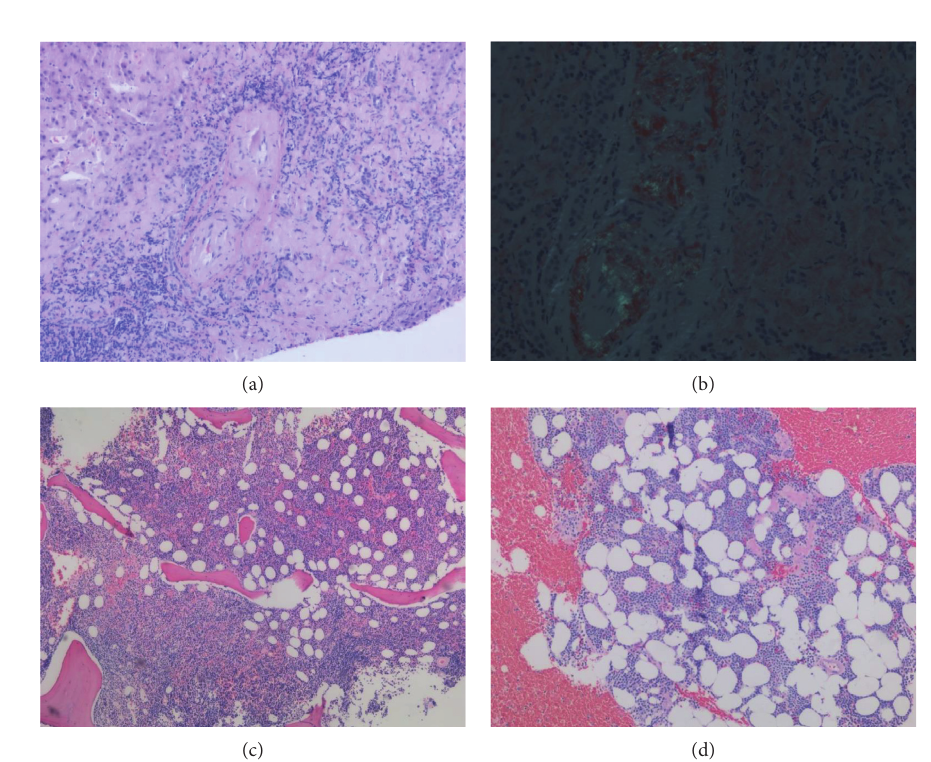
Figure 2: Change of IgM in patients.